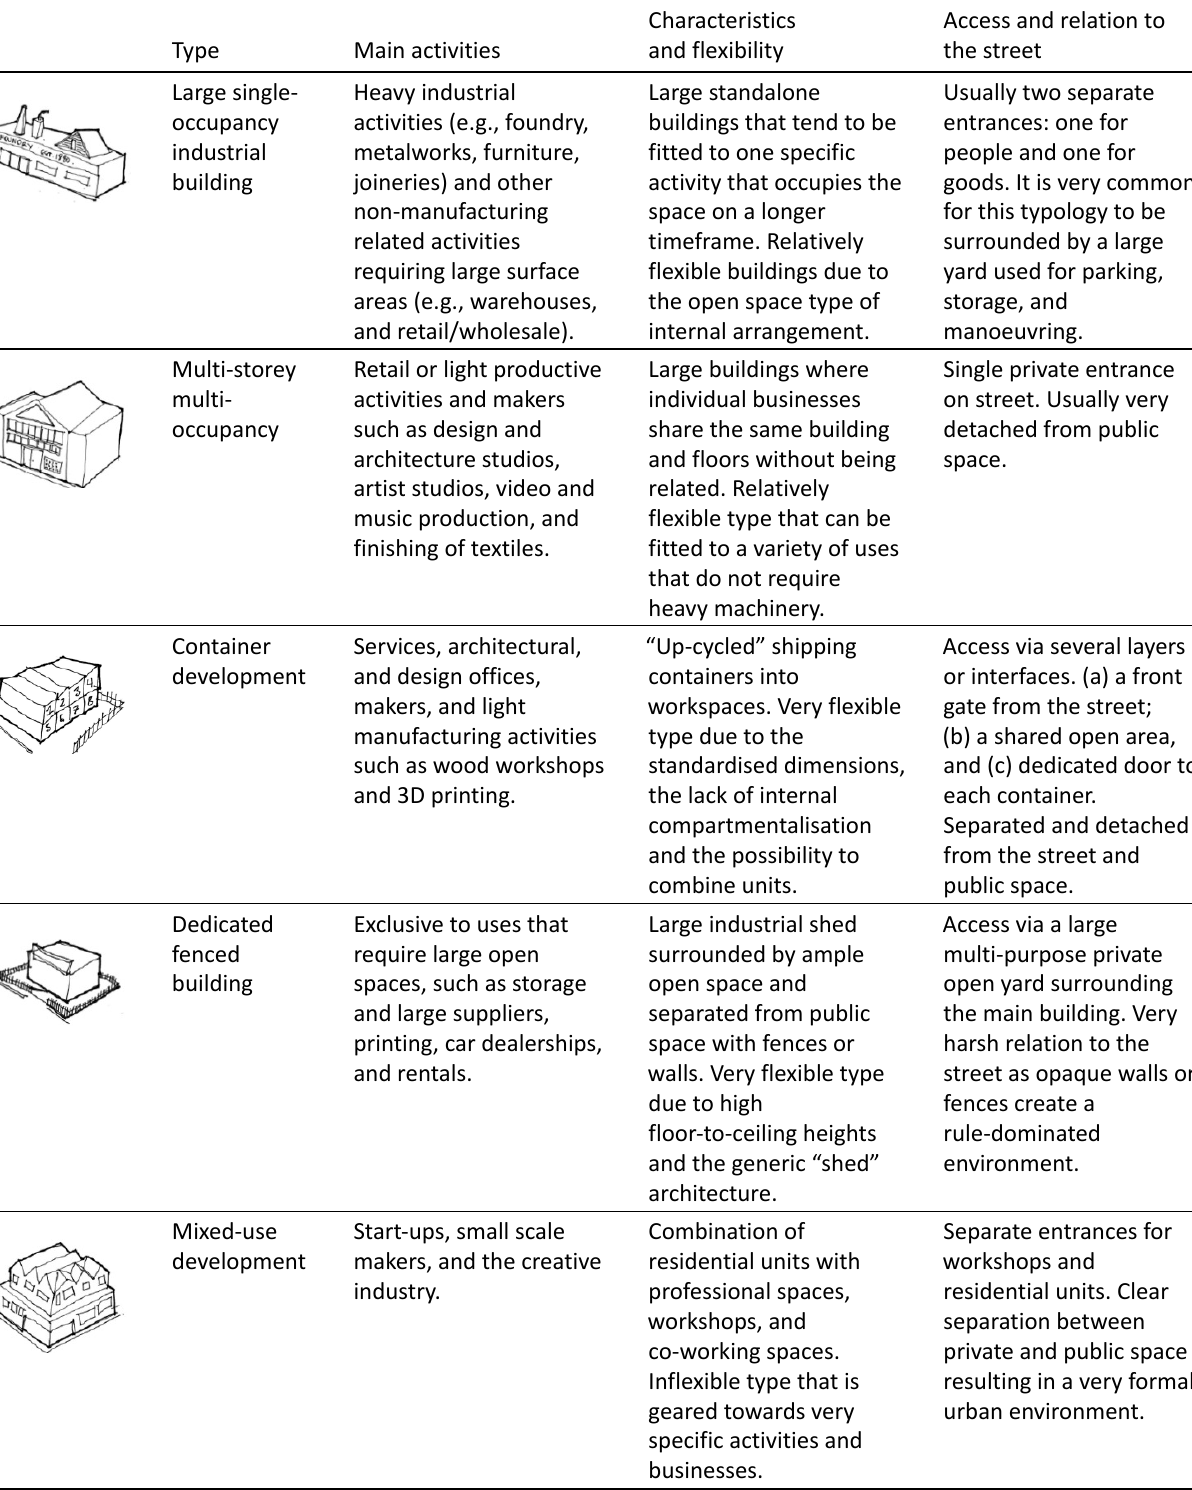
Table 1. Summary of activities, main characteristics, and accessibility of each type of manufacturing building as found in Hackney Mare Street and Old Kent